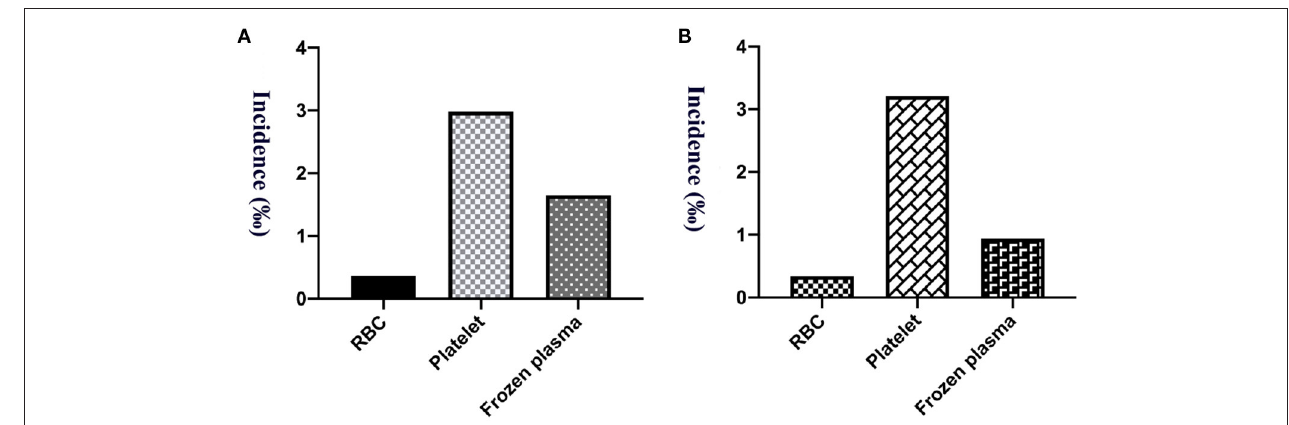
FIGURE 2 | The incidence of transfusion reaction from 5 years of RBCs, platelets and frozen plasma. (A) Per person count. (B) Per blood product count.